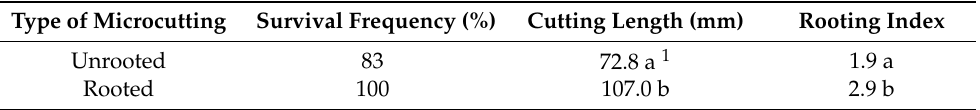
Figure 6. Development of the root system of culinary rhubarb ’Malinowy’ on a 1–3 scale. Table 5. Effect of microcutting status (rooted, unrooted) on survival, shoot growth and root system development of Rheum ‘Malinowy’ after 4 weeks of growth ex vitro (growing